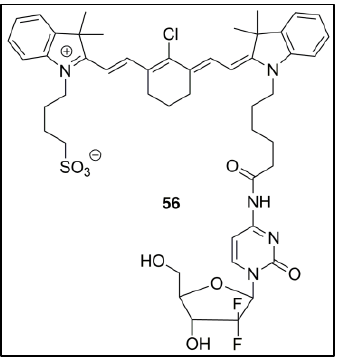
Figure 54. Structure of compounds 56 [161].